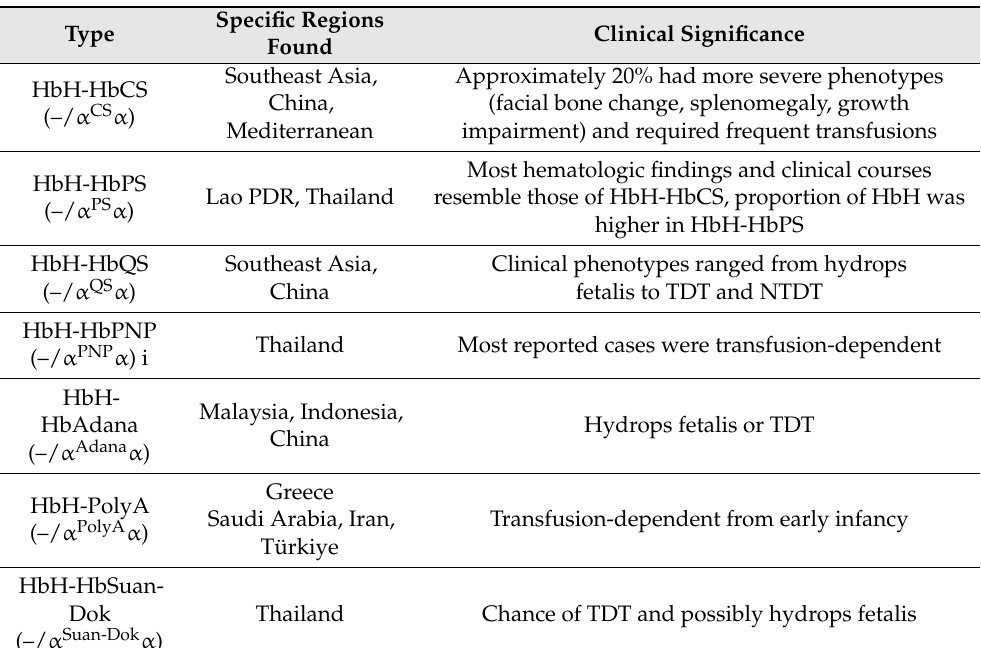
Table 2. Clinical significances of non-deletional